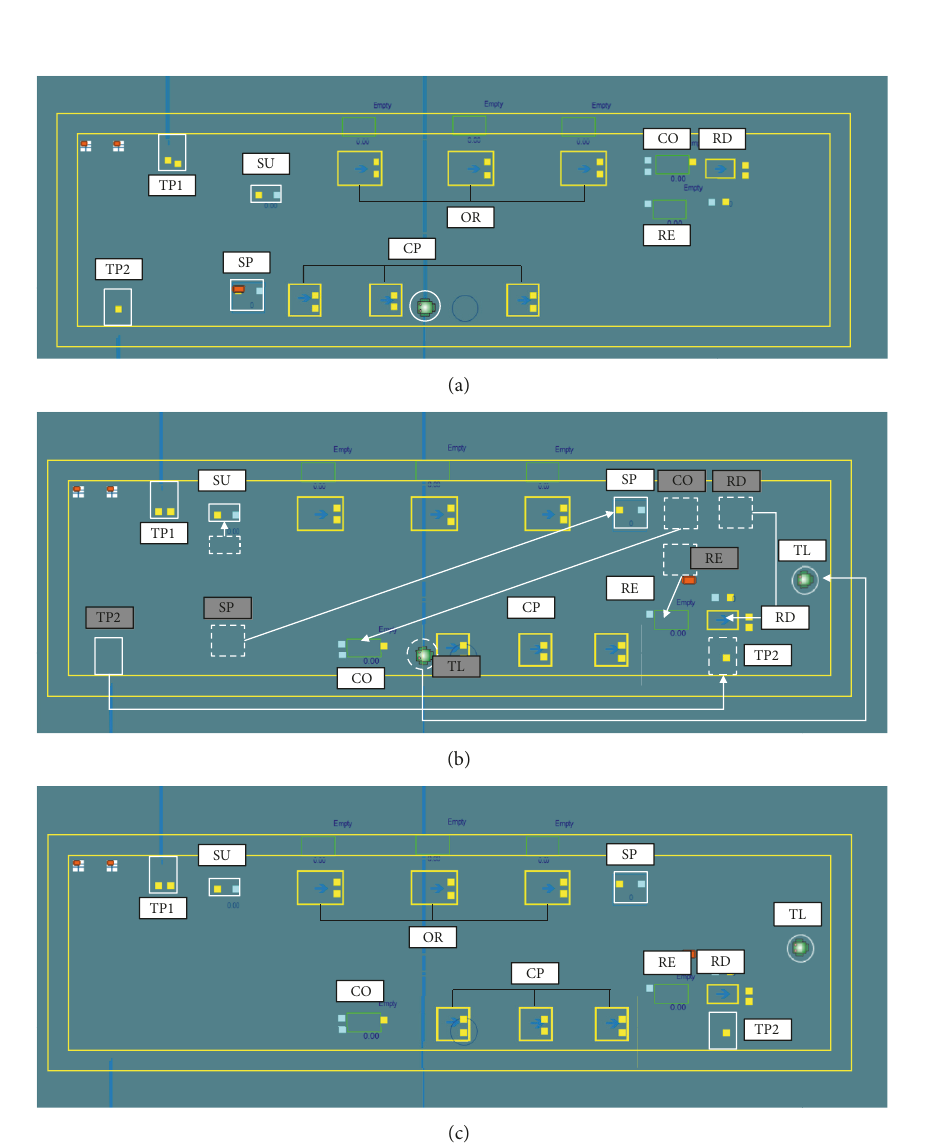
Figure 9: Layout modification in WITNESS ((a) initial layout; (b) layout modification; (c) after modification).